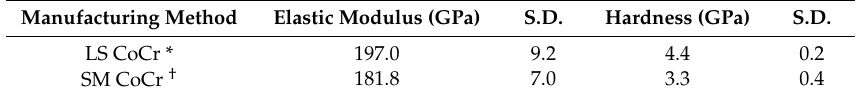
Table 3. Elastic modulus and hardness nanoindentation results for both manufacturing methods.